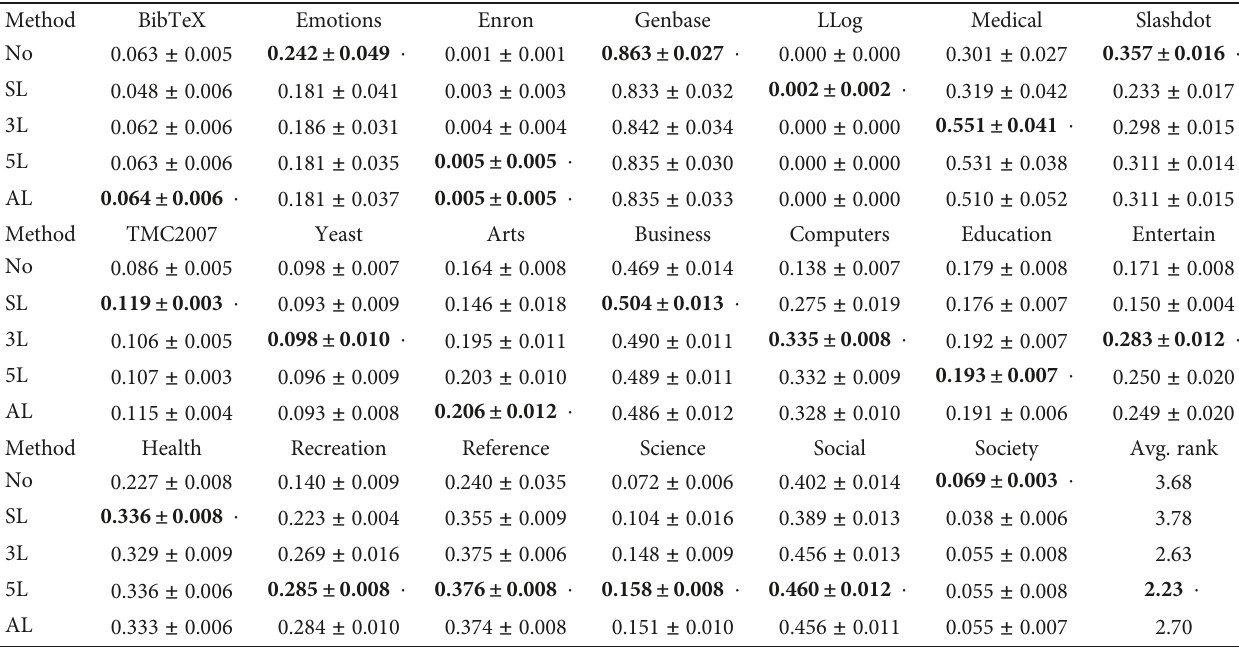
Table 5: Subset accuracy ( ↑ ) performance of each comparing method (mean ± std. deviation) on 20 multilabel